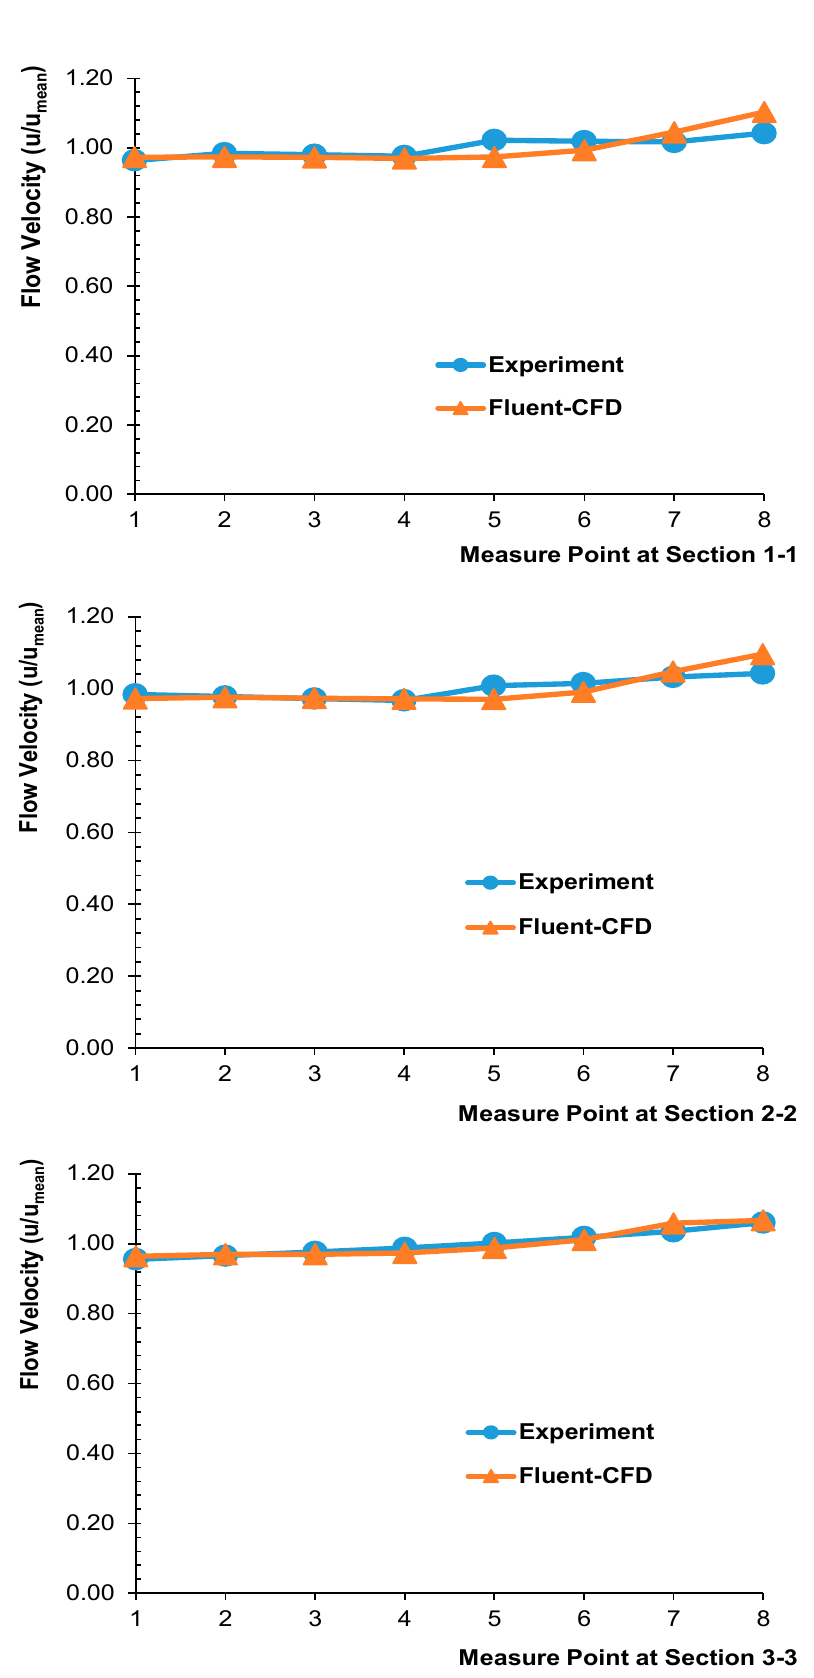
Figure 7. Flow velocity variation for without vane situation at Sections; 1-1, 2-2 and 3-3.